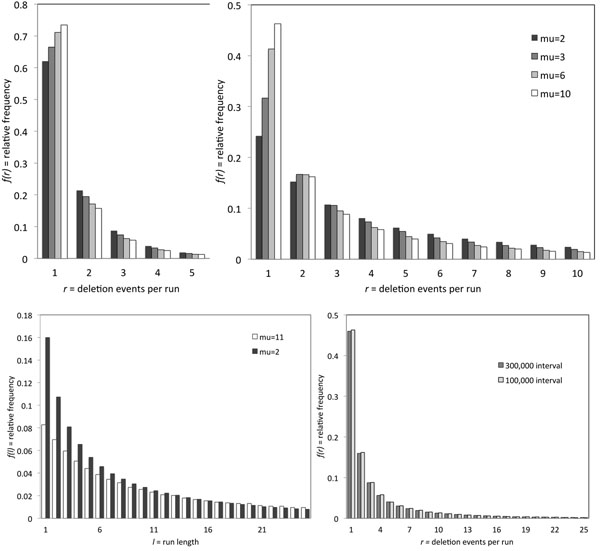
Run statistics Distribution of number of deletion events r composing each run when the proportion of sequence deleted is 0.5 (top left) and 0.9 (top right). Distribution of run length, reflecting a mixture of negative binomial distributions, for two values of the parameter of the underlying geometric distribution (bottom left). Identical results for simulation interval of 100,000 or 300,000 genes (bottom right).